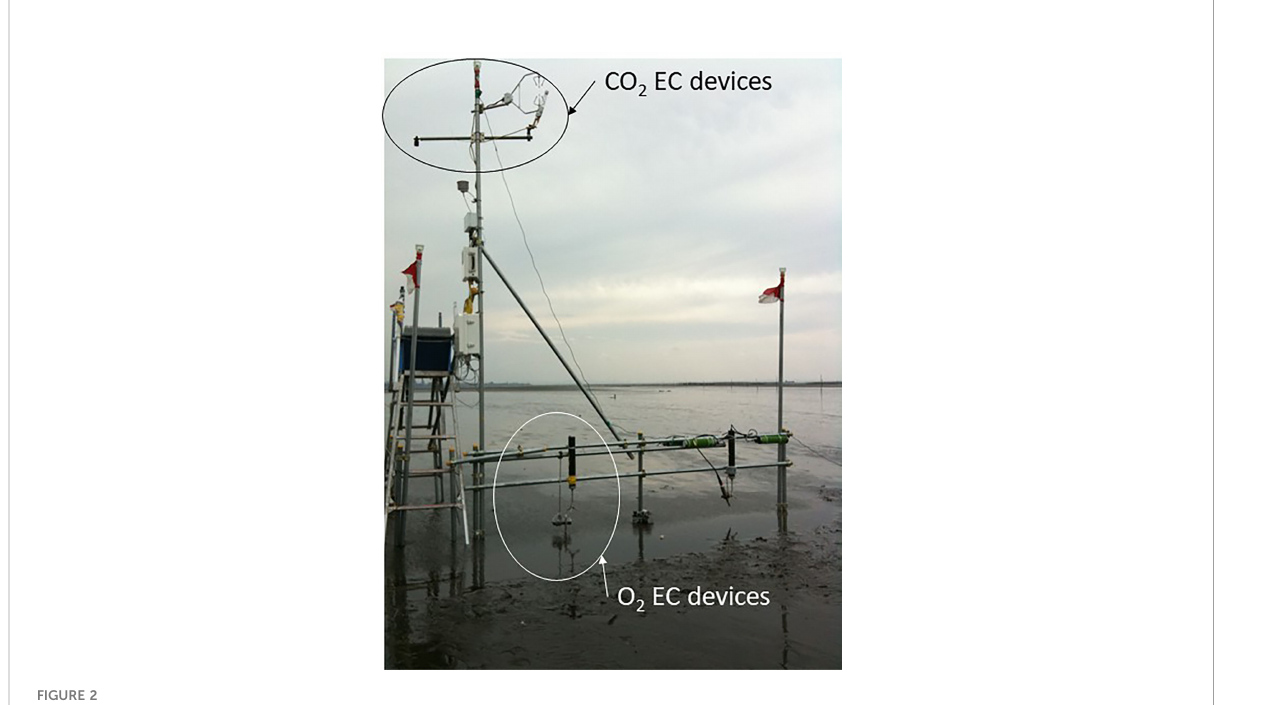
FIGURE 2 Platform for CO 2 EC and O 2